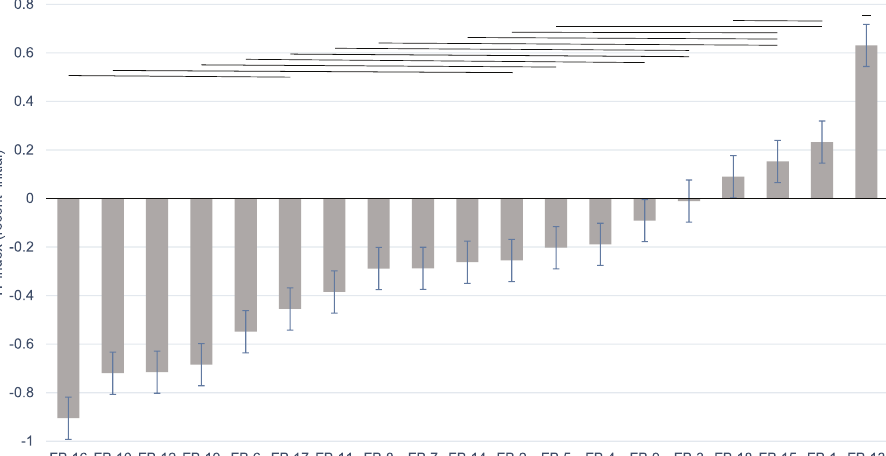
Figure 2. Bar plot depicting changes in the Shannon-Wiener diversity index (i.e. H’; recent minus ini- tial). Negative values show a decrease in diversity while positive values represent an increase in diversity over the study period. Segment lines show the standard error. Lines above the bars indicate significant differences amongst the flowerbeds at the level of p < 0.05 (Tukey’s HSD test).